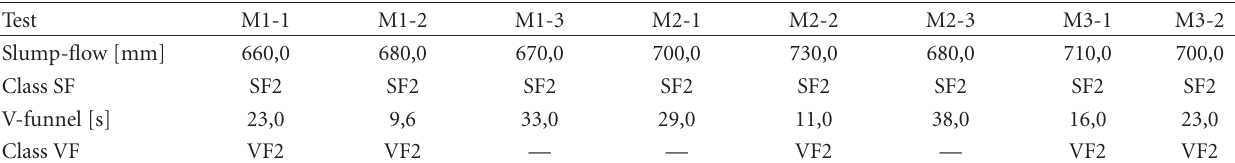
Table 3: Slump-flow and V-funnel